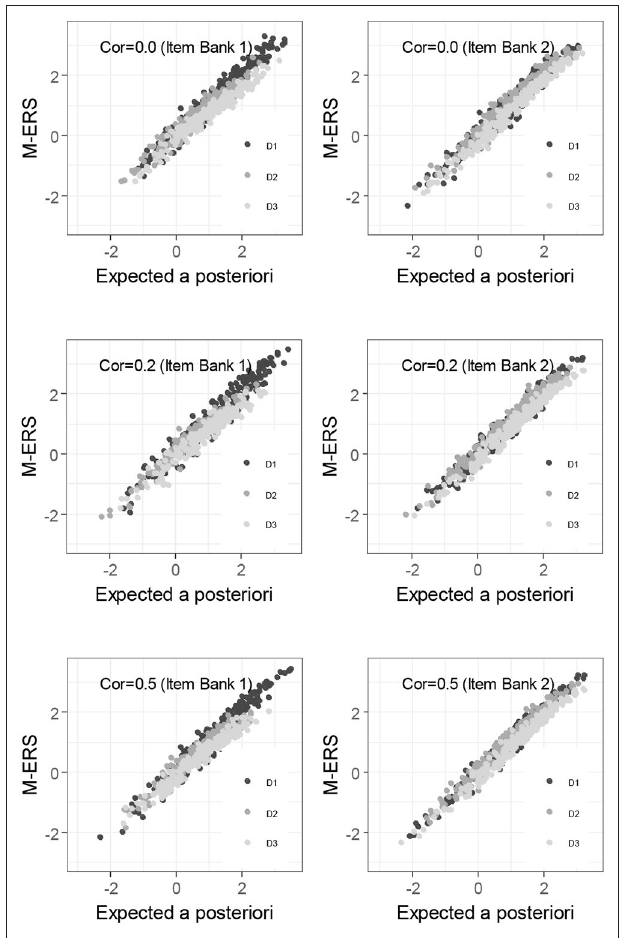
FIGURE 3 | Relations between EAP and M-ERS